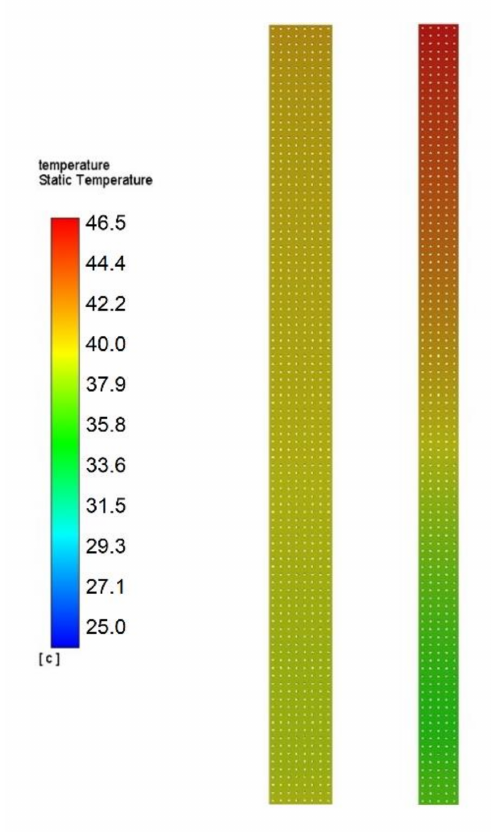
Figure 14. Distribution of the temperature on the perforated absorber plate of the 30 cm ( left ) and 10 cm ( right ) thickness DTSC with an air flow of 500 m 3